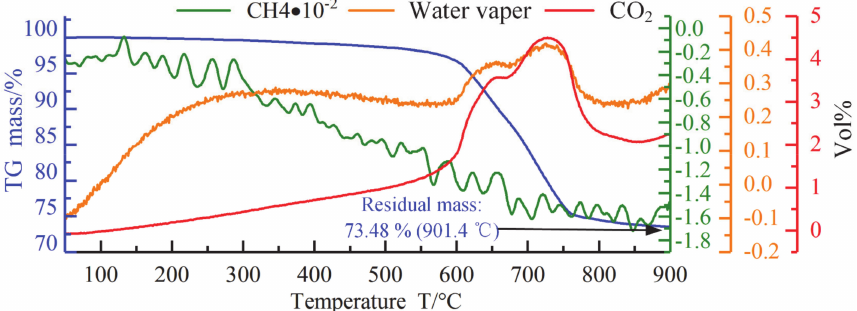
Figure 5. TG-IR analysis of flux